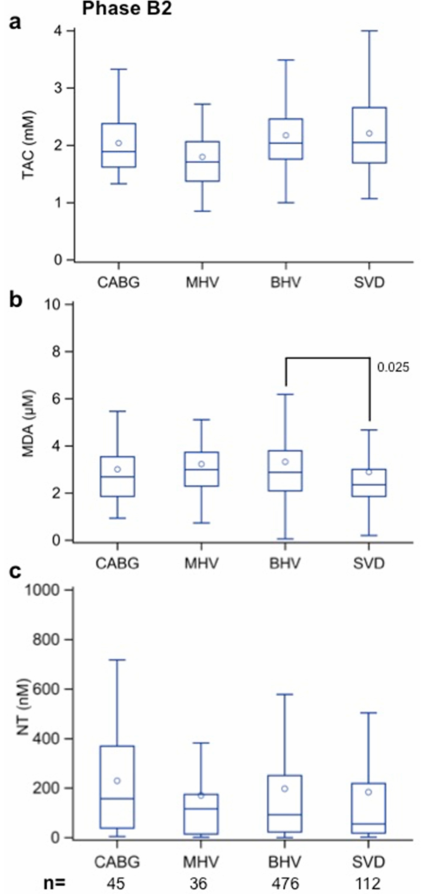
Figure 5. ( a ) Total antioxidant capacity (TAC, in mm), ( b ) malondialdehyde (MDA, in µ m), and ( c ) nitrotyrosine (NT, in nm) values in patients diagnosed with structural valve disease (SVD—Phase A) and in Phase B2 patients with implanted aortic biological heart valves (BHV) at the time of recruitment (>48 months after surgery). Patients undergoing coronary artery bypass (CABG) surgery and aortic valve replacement with a mechanical heart valve (MHV), also recruited >48 months after surgery, served as the controls. The numbers within the figures represent the p -values, and the numbers at the bottom of the figures represent the number of assessed patients. Multiple comparison adjustments were performed with Dunnett’s and Tukey–Kramer’s